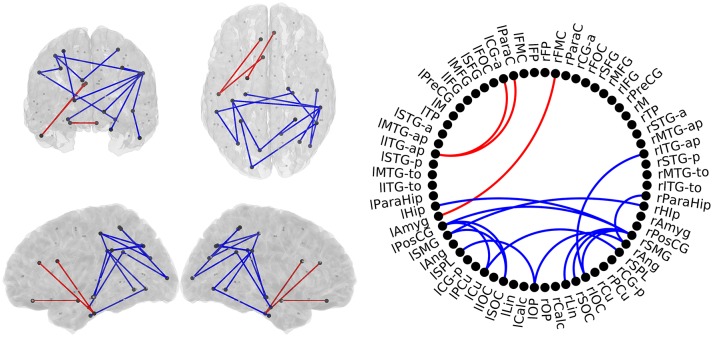
Links with significantly different FC-values in the comparison between Healthy Controls (HC) and Mild Cognitive Impairment (MCI) groups. Left : Posterior, superior, left, and right views of the brain. Right: Circle plot shows a schematic view of the significant links. Red lines indicate an increased FC-value in MCI respect to HC. Blue lines indicate a decreased FC-value in MCI respect to HC.